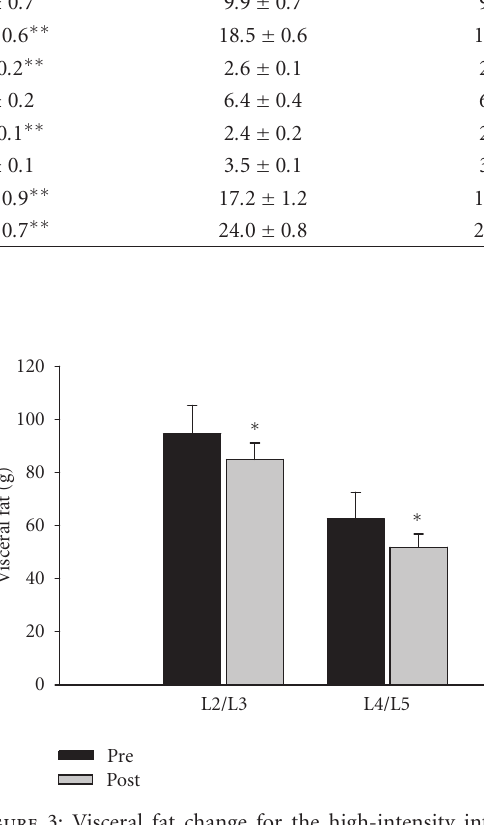
Figure 2: Fat-free mass change for the high-intensity intermittent exercise groups ( N = 38; mean and standard error). ∗ Significant di ff erence between pre- and posttesting ( P < 0 . 05).